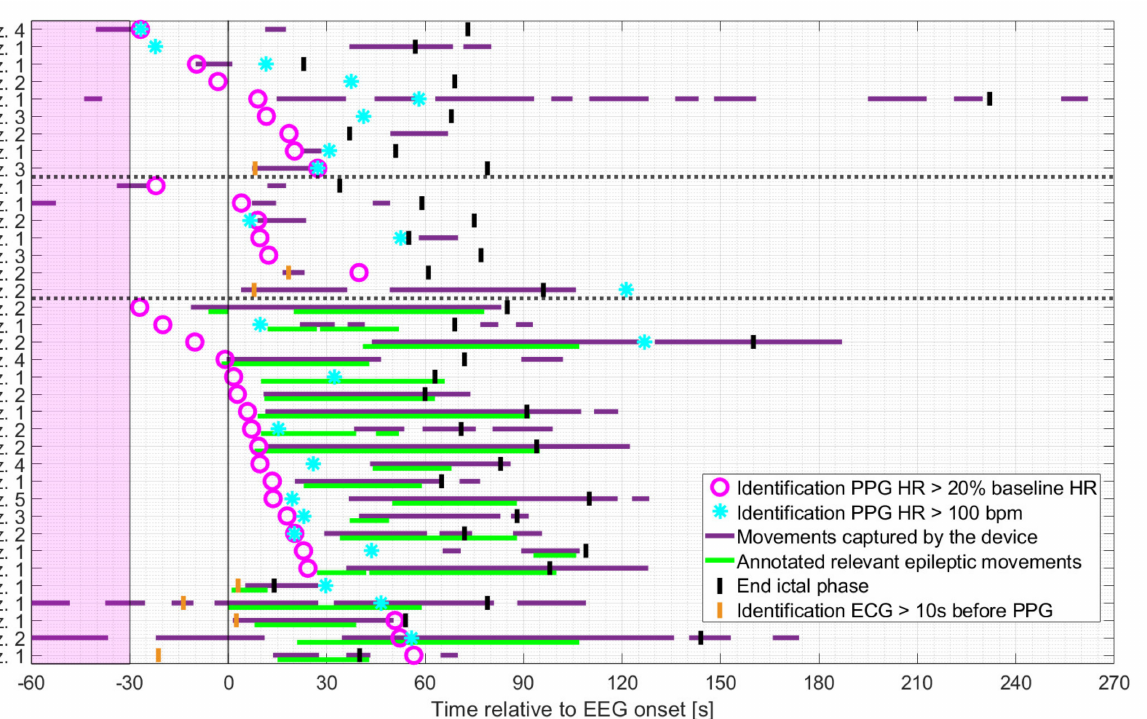
Figure 5. Seizures rated as hits ordered by timing of identification of IT relative to EEG onset, based on the earlier of the two PPG-based threshold crossings, and divided into non-motor seizures, seizures with non-relevant epileptic movements, and seizures with relevant epileptic movements (in this order and separated by the dashed horizontal lines). The timing of identification of the earlier of the two ECG-based threshold crossings is plotted for those cases in which identification based on PPG occurred at least 10 s